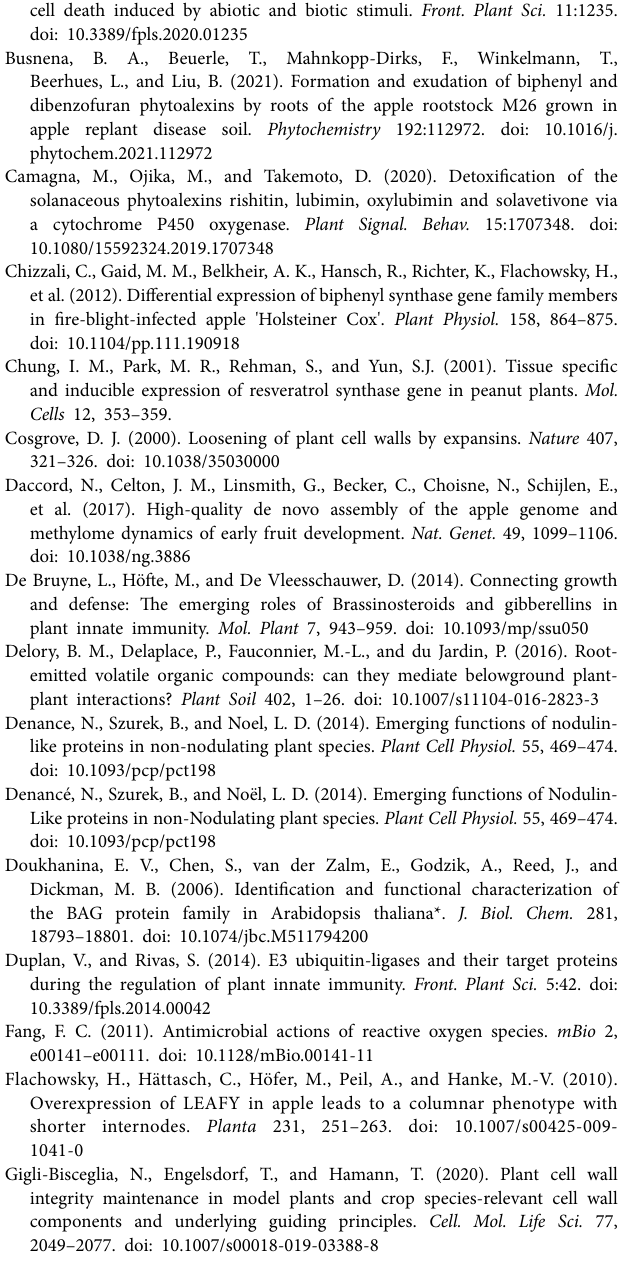
Supplementary Table 2 | String input and output for the susceptible rootstock ‘M9’ and the ARD tolerant wild apple accession M. ×robusta 5 (Mr5). Supplementary Table 3 | Results of the primer validation. Supplementary Figure 1 | Normalized gene expression of the three biomarker genes biphenyl synthase 3 ( BIS3 ), biphenyl 4-hydroxylase ( B4H ) and ethylene- responsive transcription factor 1B-like ( ERF1B ) for the susceptible rootstock ‘M9’ and the ARD tolerant wild apple accession M. ×robusta 5 (Mr5) after cultivation in ARD soil and γ ARD soil,